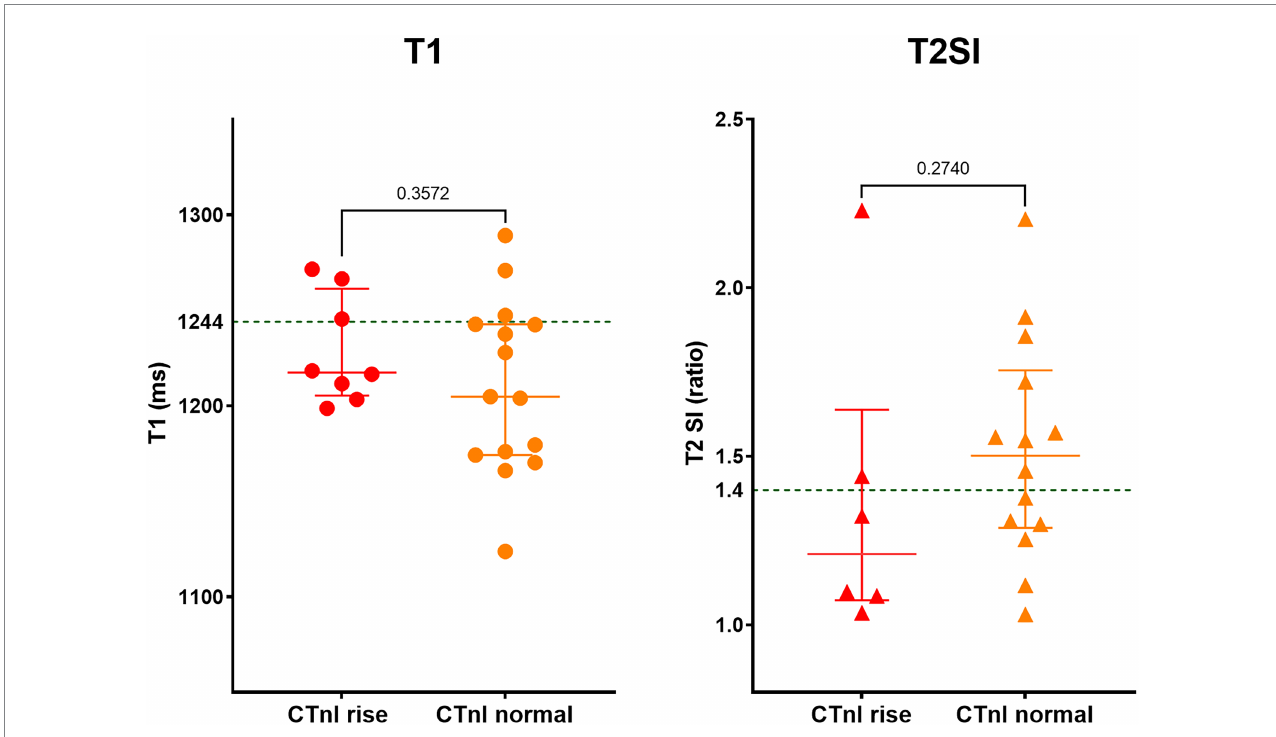
FIGURE 2 Myocardial tissue characteristics on CMR during acute COVID-19 in hospitalized patients with and without mild cardiac Troponin (CTnI) rise. Out of 23 patients, eight had mildly elevated CTnI levels (on average 2.4-fold above normal range). Green dotted line in the graphs denotes the upper limit of normal range for T1 and T2SI ratio in the 3 T MR scanner used for this